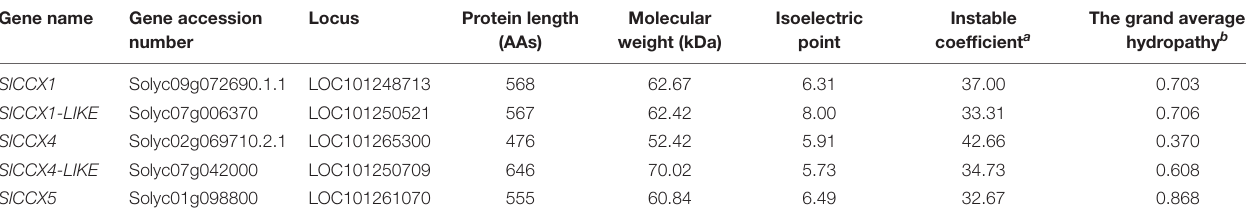
TABLE 1 | CCXs gene information in tomato.